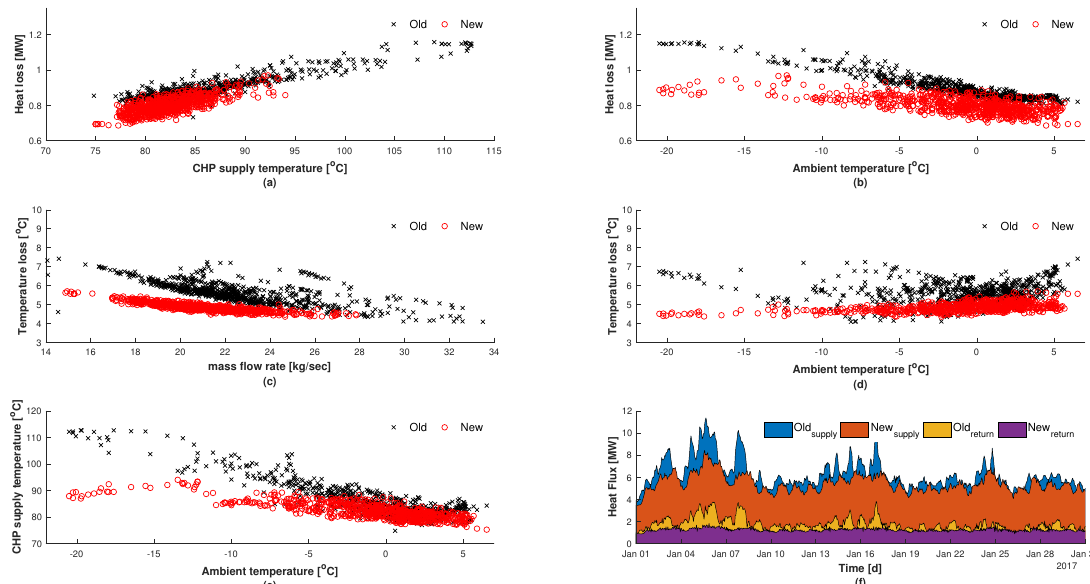
Figure 8. Improvements gained from Scenario 1 (feed-forward historic load). ( a , b ) represent the associated heat losses in respects to CHP supply temperature and the ambient temperature respectively; ( c , d ) represent the temperature losses in respects to the mass flow rate and ambient temperature respectively; ( e ) CHP supply temperature in respects to ambient temperature; ( f ) Comparison between historical values (old) and control values (new) in regards to rate of heat supplied and returned in the